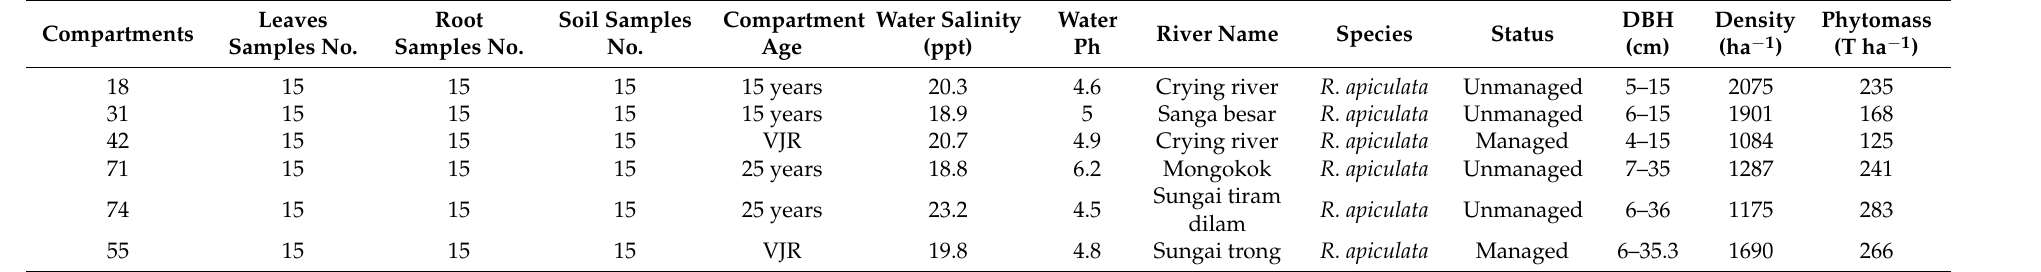
Table 4. Number of samples collected with the environmental parameter information of each compartment